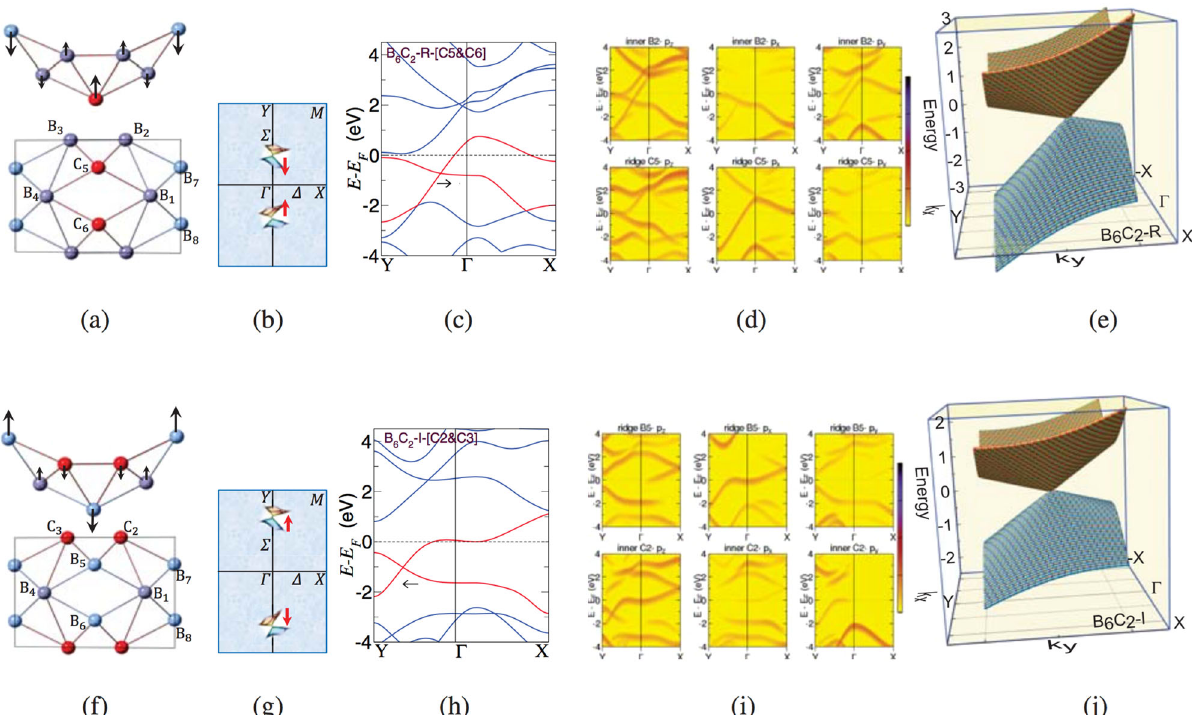
Fig. 5 Manipulation of the tilt of Dirac cone by carbon substitution in 8 Pmmn borophene. a Top view of crystal structure of B 6 C 2 -R-[C5 & C6] and b its Brillouin zone. The red circles denote carbon atoms. c Density functional theory with Perdew-Burke-Ernzerhof (DFT-PBE) band structure of B 6 C 2 -R- [C5 & C6], d its orbital-projected band structures for two atoms and ( e ) its three dimensional reconstruction. f – j The same as ( a – e ) for B 6 C 2 -I-[C2 & C3]. The horizontal arrows in panels c and h indicate the direction of the displacement of the Dirac node with respect to the parent B 8 . The vertical arrows in a and f show the direction of movement of the lattice sites upon carbon